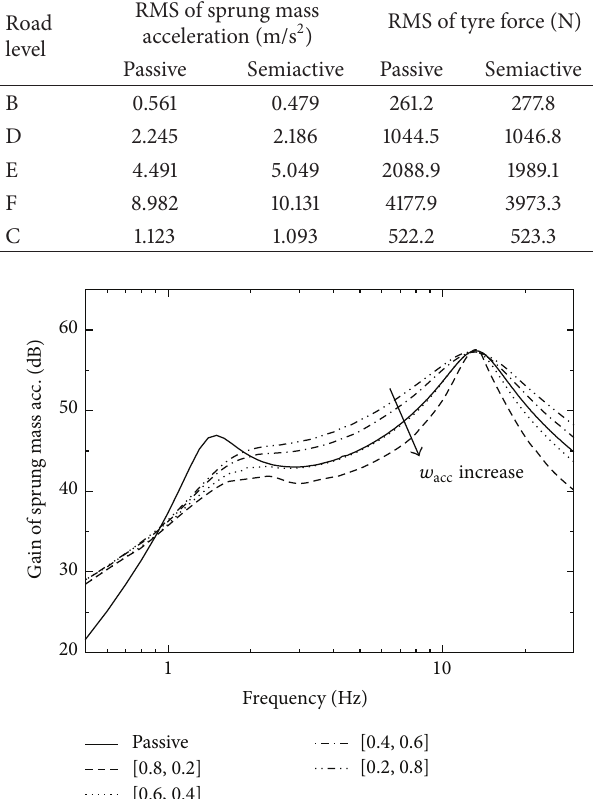
Figure 9: Comparison of frequency responses of ̈𝑥 𝑏 /𝑥 𝑟 for different control weights.